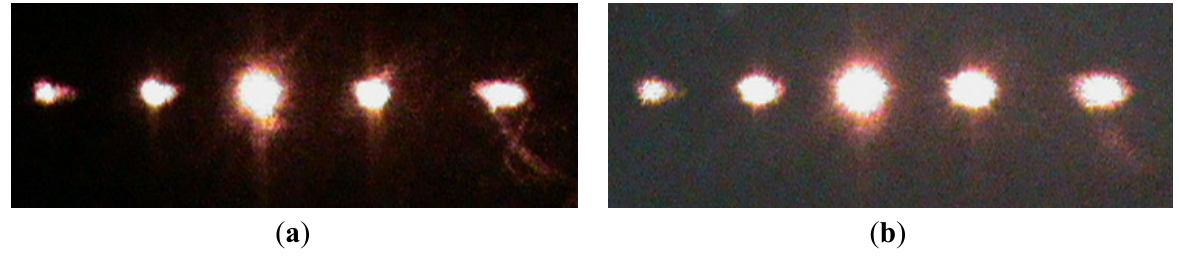
Figure 13. Diffraction pattern, ( a ) without voltage and ( b ) with voltage of 30 V, for grating with 454 lines/mm, made from sample